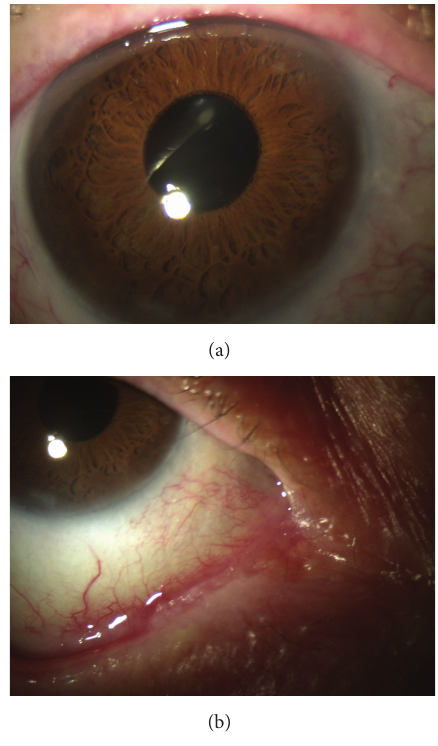
Figure 9: Right eye after therapy.